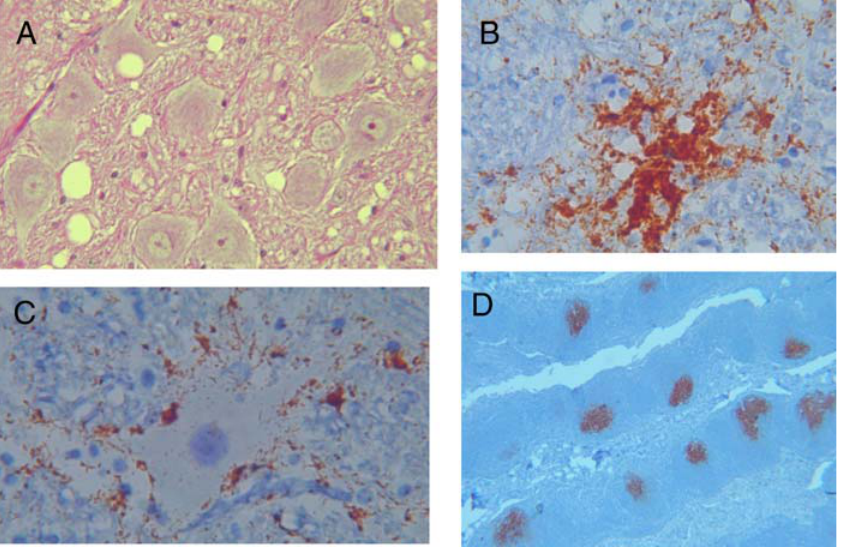
Figure 2. Pathology in CWD-Infected Animals (A) Histologic lesions of CWD in the dorsal motor nuclei of the vagus nerve within the medulla oblongata of a CWD-affected elk. Note spongiform change, intraneuronal vacuoles, and mild gliosis (hematoxylin and eosin stain, 100 3 magnification). (B) PrP amyloid deposit stained by immunohistochemistry (brown) and surrounded by vacuoles (original magnification 180 3 ). (C) Perineuronal and extracellular deposits of abnormal PrP (PrP CWD , analogous to PrP Sc ) in a CWD-affected mule deer (original magnification180 3 ). (D) PrP CWD deposits in the germinal centres of lymphoid follicles in the tonsils of a mule deer (immunohistochemistry, original magnification 50 3 ).